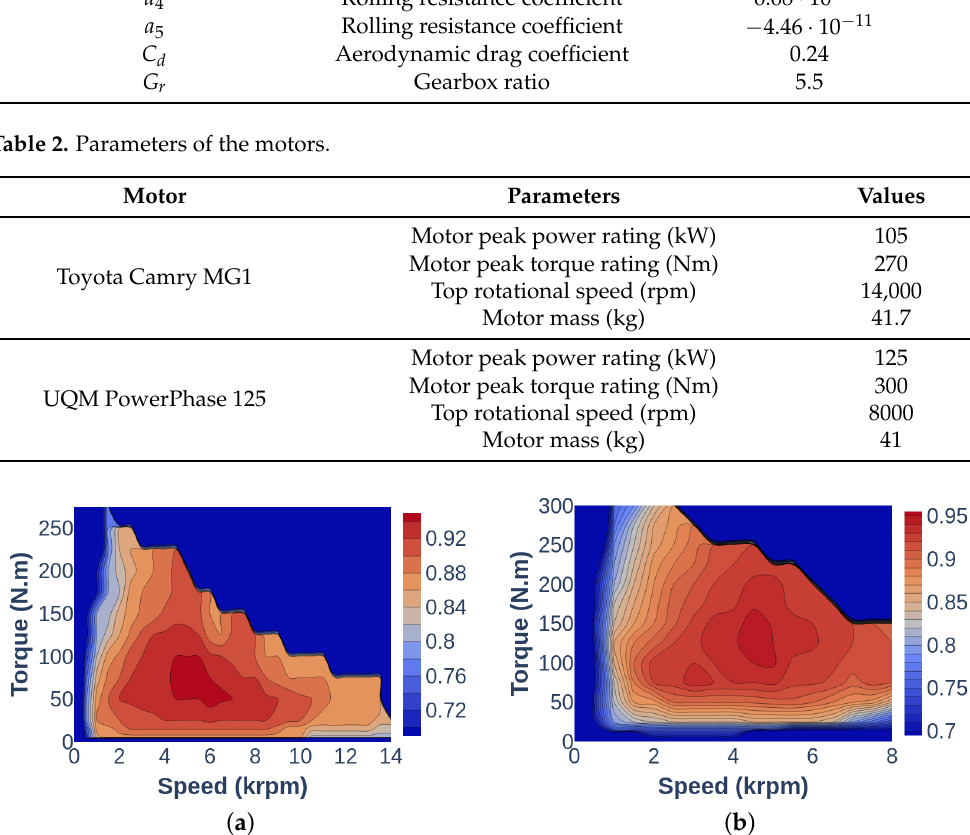
Figure 4. Efficiency maps: ( a ) Motor 1; ( b ) Motor 2. Adapted from